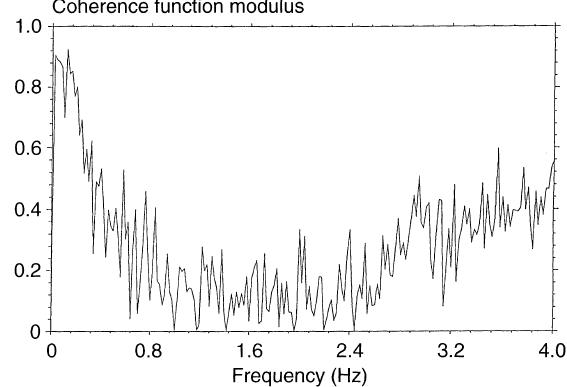
Fig. 4. Modulus of coherency function calculated for B z components of AMPTE UKS and AMPTE IRM magnetic fields for the time interval 650–1100 s